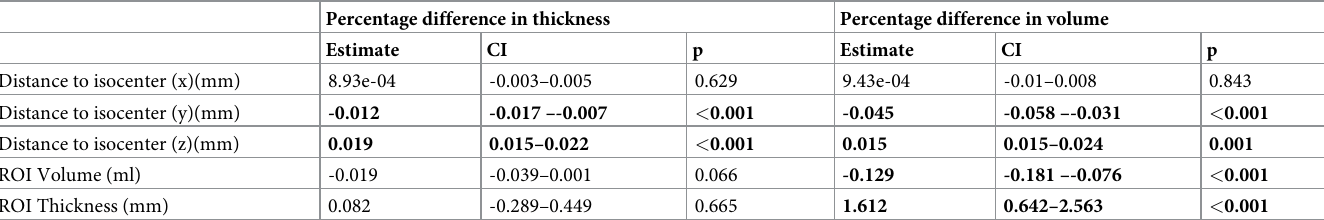
Table 2. Results of the multiple linear regression